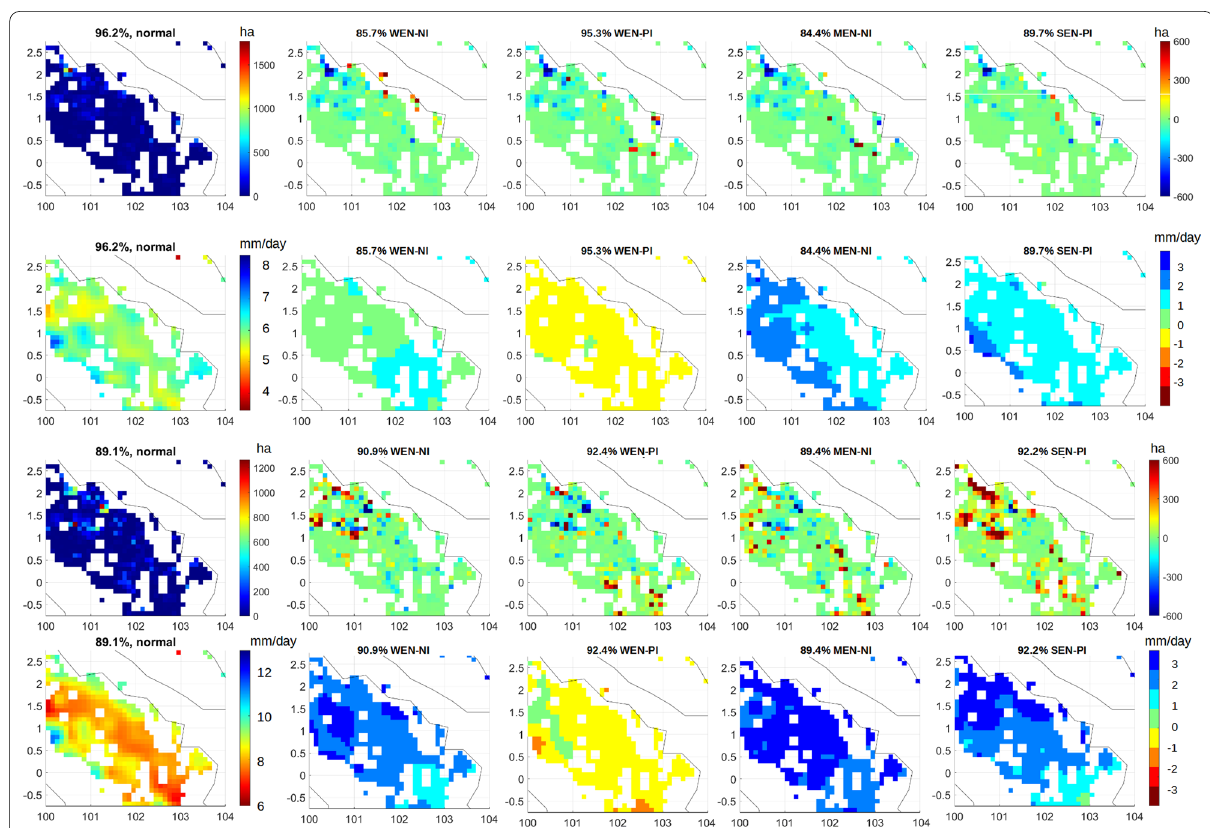
Fig. 10 Spatial joint Pattern on Riau (1st ba, 1st prec, 2nd ba, 2nd prec). In a normal graph, the colour represents an average of total burned area for each grid in the composite year only during fire season (January–March for the 1st dry season, May–November for the 2nd dry season). Other categories represent the difference between each category with value in a normal